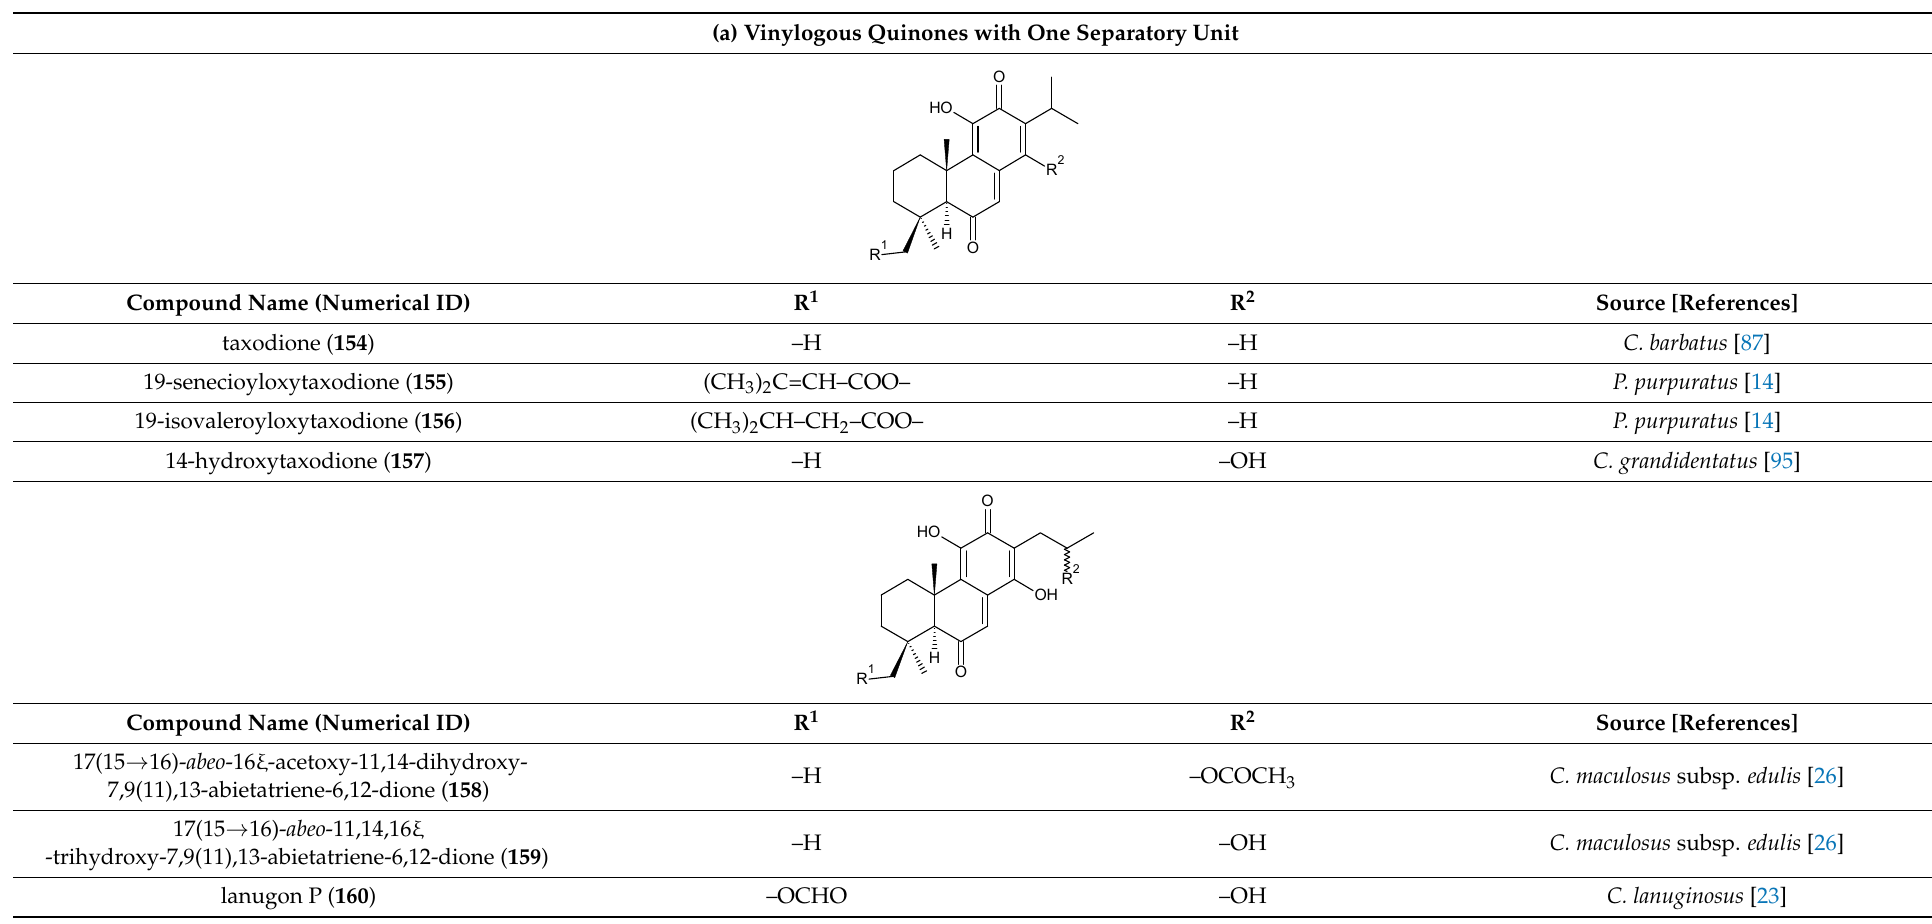
Table 4. Vinylogous quinones of the genus Plectranthus s.l.